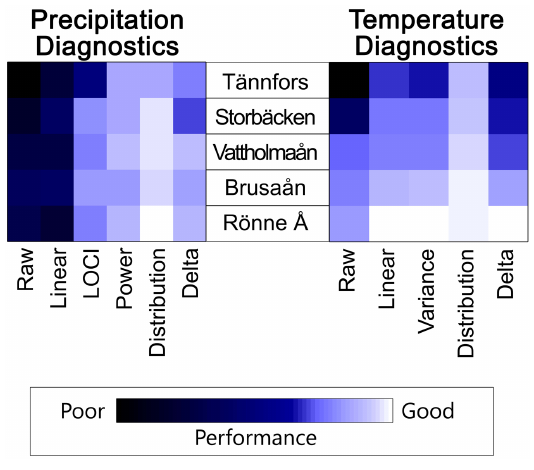
Fig. 9. Overall performance of precipitation (left) and temperature (right) biases correction methods. Each panel displays model error information depending on the applied bias correction methods ( x axis) and the 5 catchment locations ( y axis). Each plot combines normalized model errors of different statistical diagnostics and was created by superimposing the different panels from Figs. 5 and 6 for precipitation (left) as well as the panels from Figs. 7 and 8 for tem- perature (right). Light color fields represent small model errors and little model error growth; darker colors characterize larger model errors and more model error